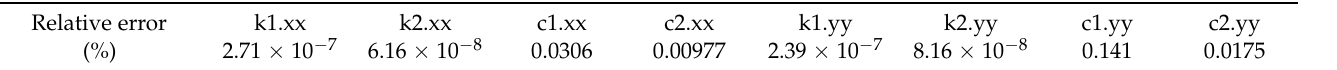
Table 14. The biggest relative identification error using the computational example